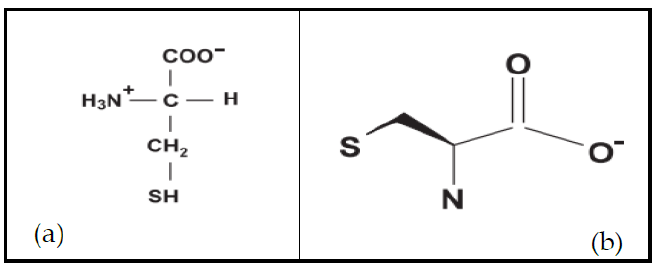
Figure 1. Chemical structure ( a ) and structural model ( b ) of an L -cysteine molecule (adapted from [1]).